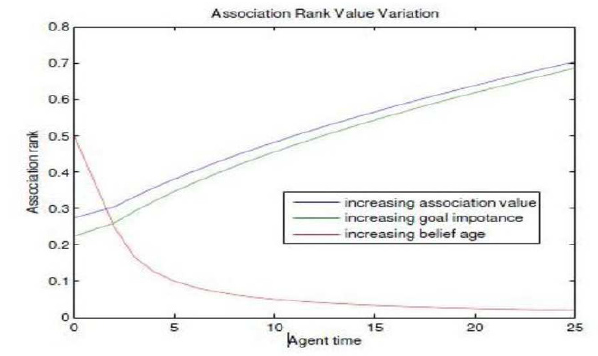
Figure 5. Effect on association rank value by major contributing factors.